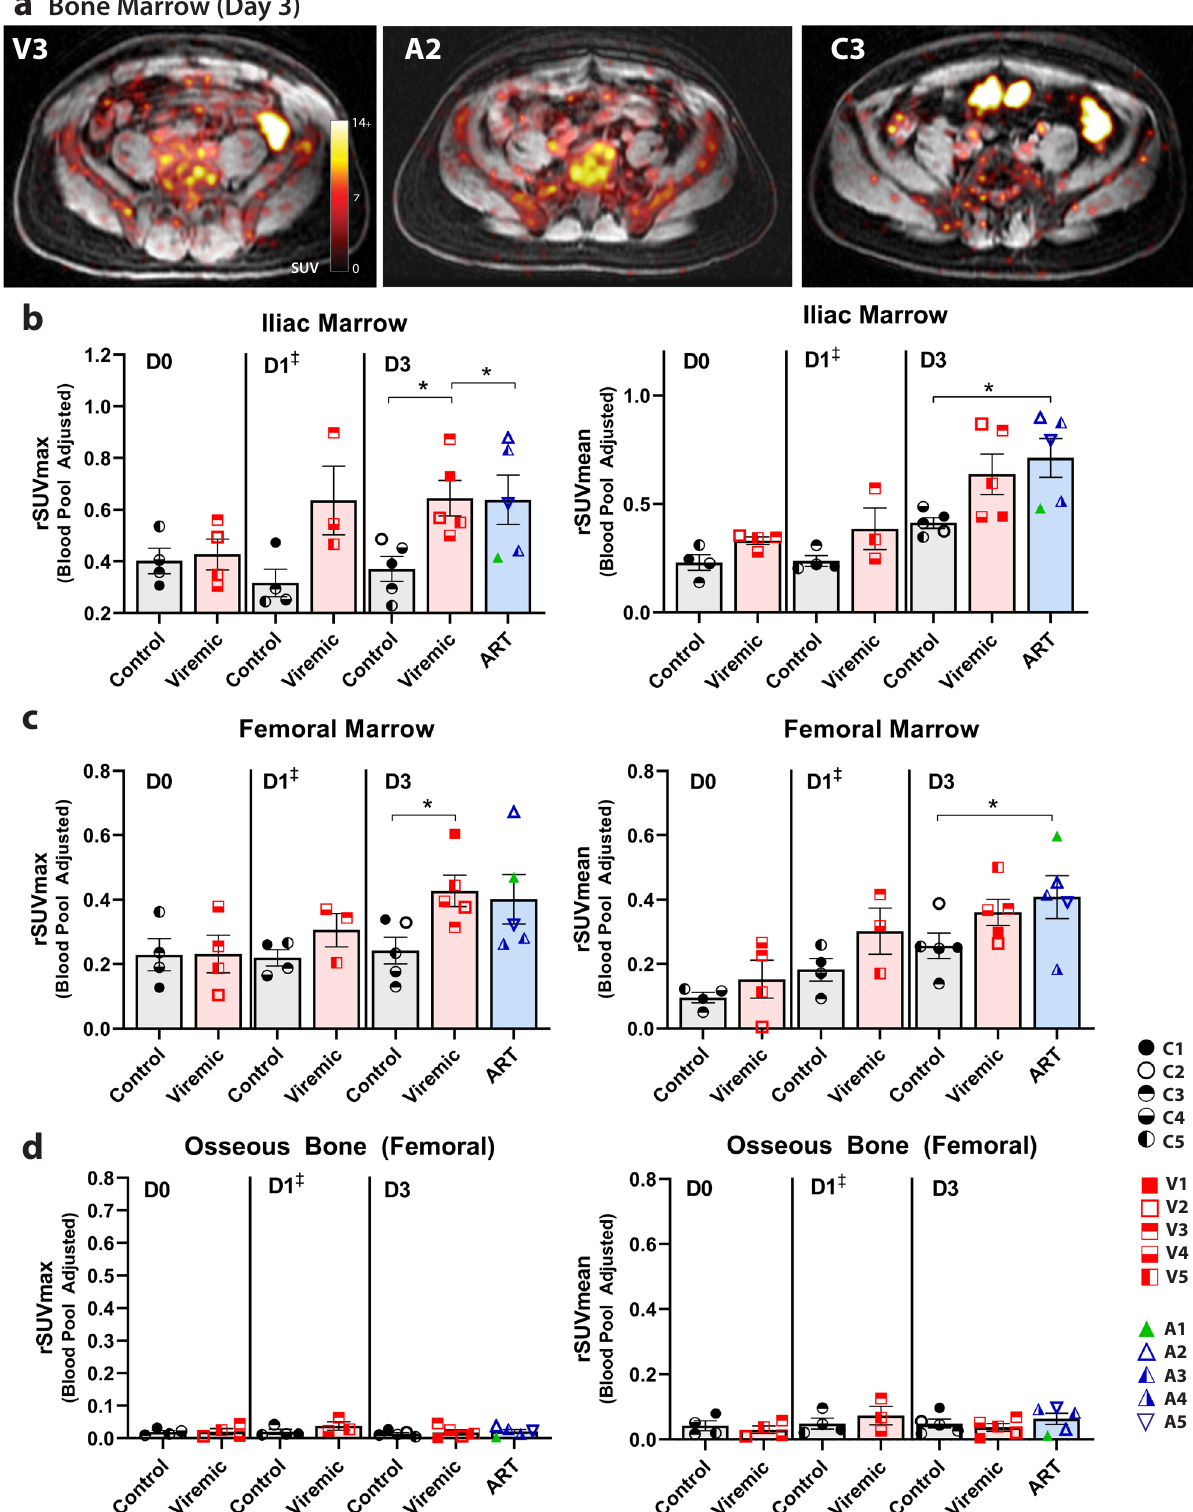
Inguinal lymph node HIV p24 levels correlate with 89 Zr-VRC01 uptake in viremic and ART-suppressed partici- pants . Correlation analyses in all HIV-infected participants revealed signi fi cant positive associations between inguinal and axially rSUVmax at imaging day 3 and plasma HIV-1 RNA levels ( r = 0.78 and 0.83, respectively, both P = 0.02), but not uptake in